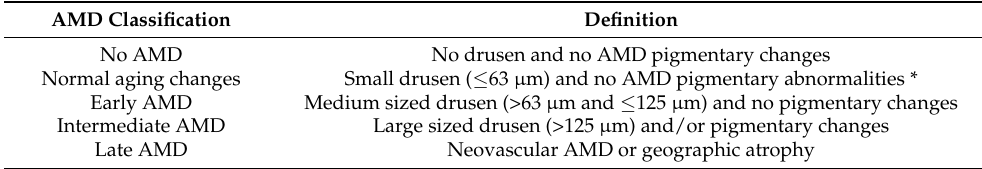
Table 1. The Beckman clinical classification of age-related macular degeneration (AMD).